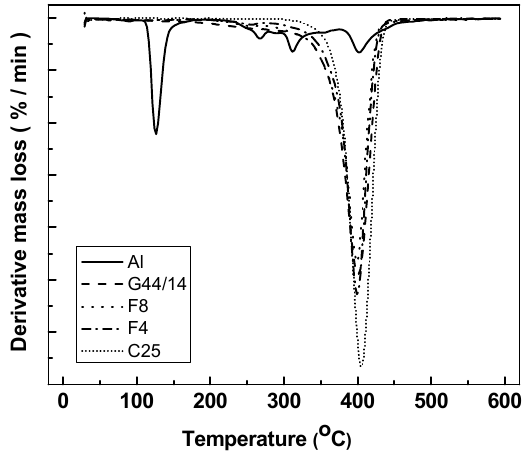
Figure 4. DTG curves for AL-loaded SLPs in F4 and F8 formulations and their ingredients.